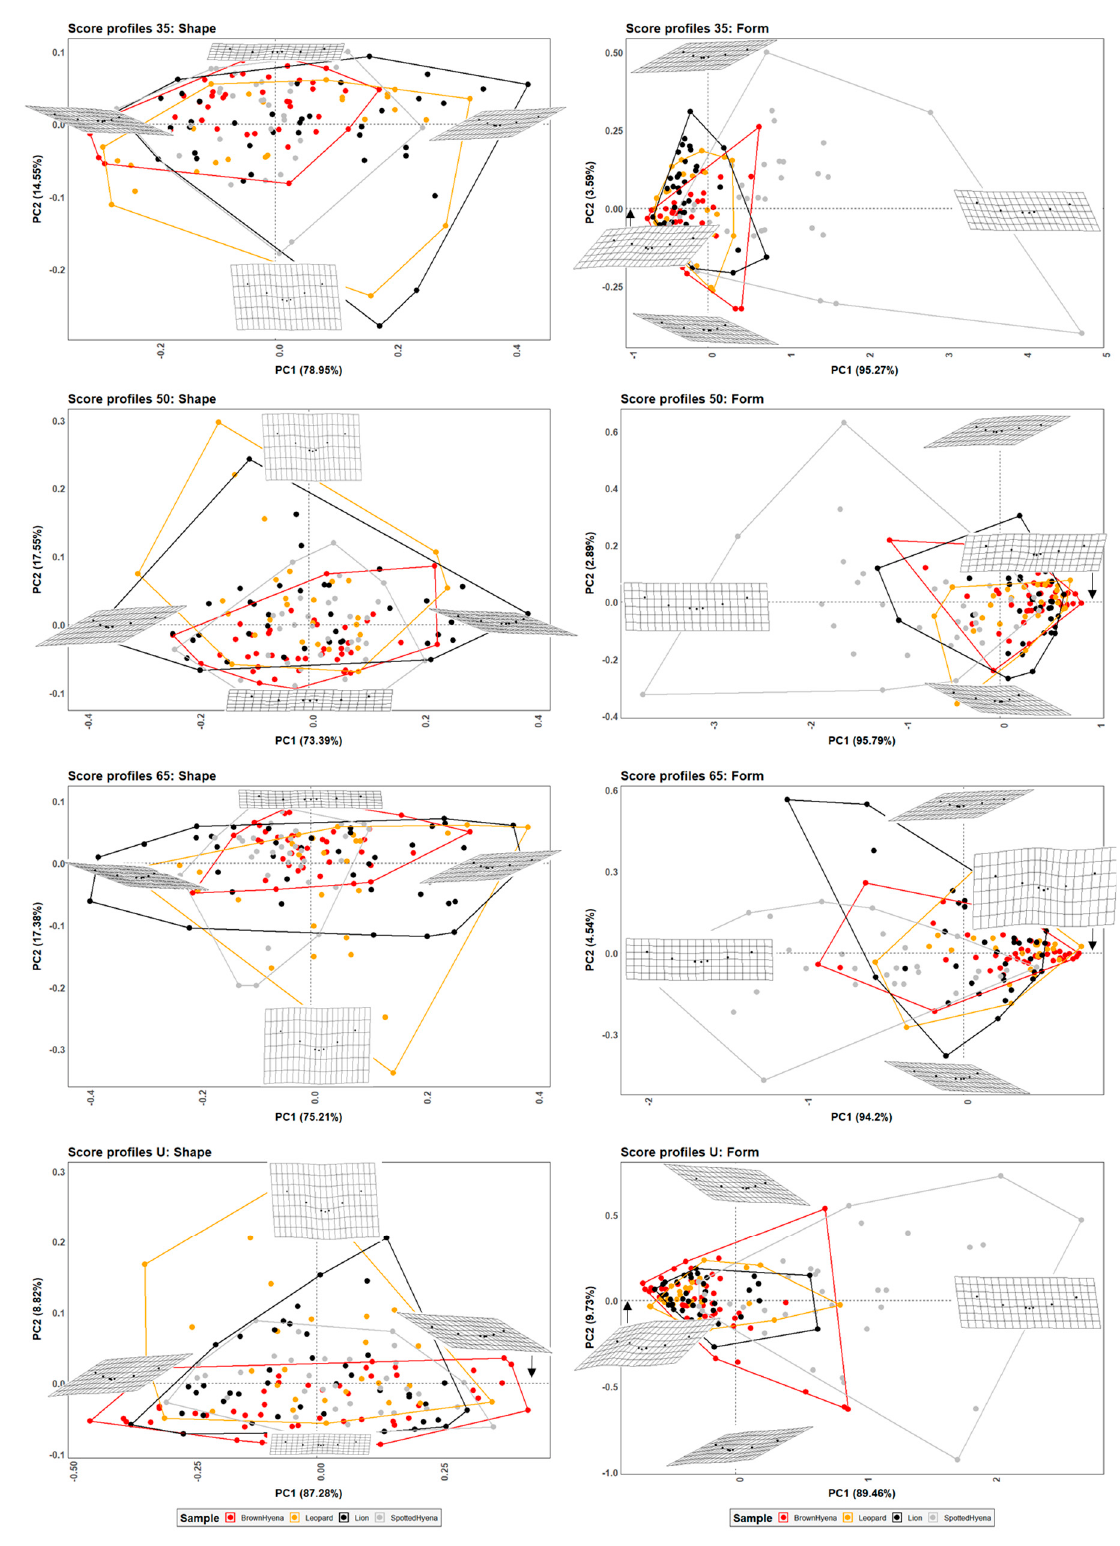
Figure 2. PCA plots in shape and form space on the 7-landmark model at 35%, 50%, and 65% cross-sectional score length, and at the most conspicuous U-shaped score section. Extreme changes in shape and form along PC1 and PC2 are illustrated with the aid of transformation grids.